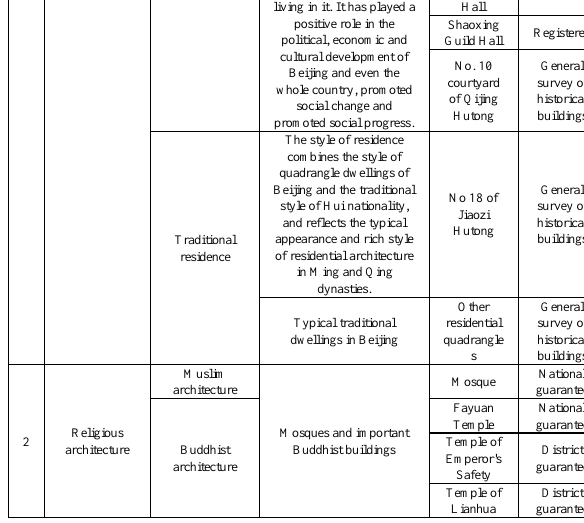
Table 2. Representative buildings in Niujie